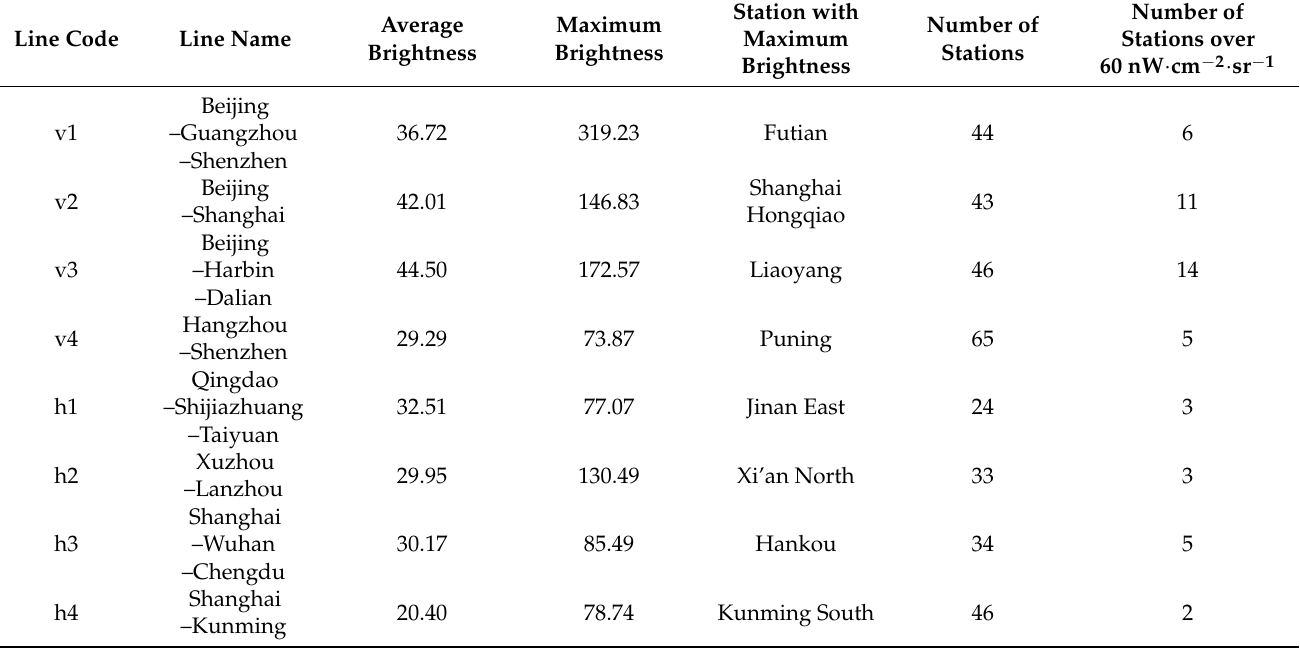
Table 2. Average brightness of four vertical and four horizontal HSR lines in 2019.